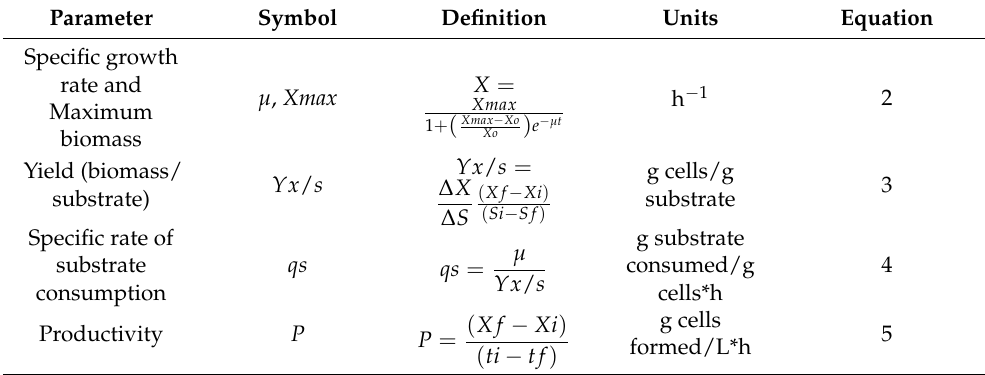
Table 1. Definition of kinetic parameters for liquid fermentation according to Aranda et al.